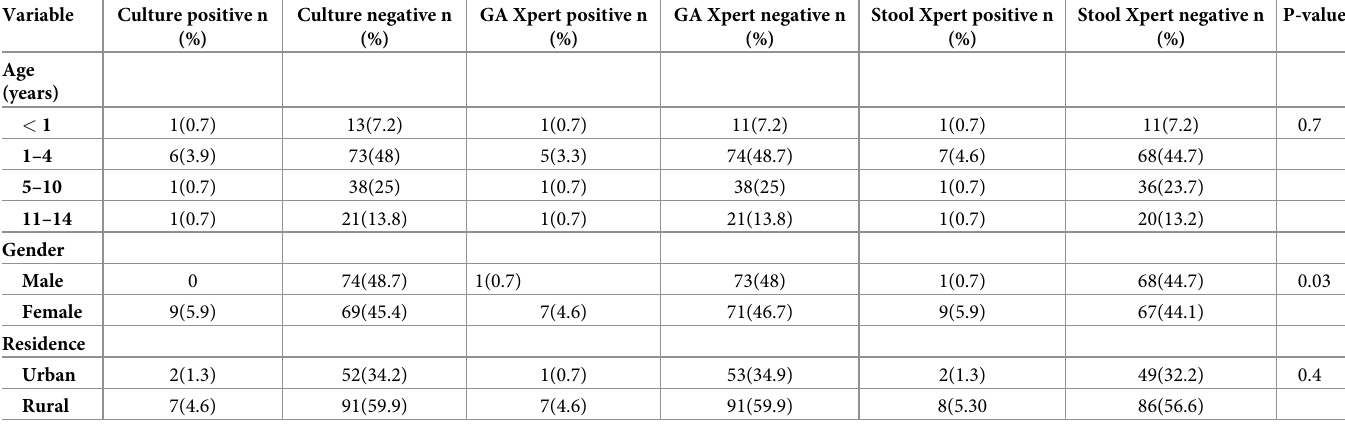
Table 1. Demographic characteristics of participants with their diagnostic